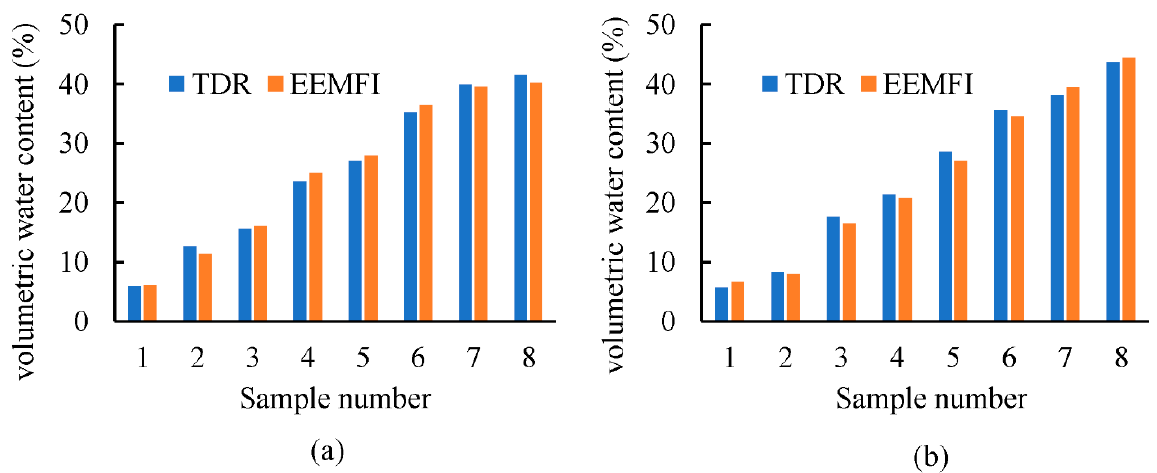
Figure 12. Comparison of accuracy of sensor measurement results: ( a ) clay loam soil and ( b ) loess soil.